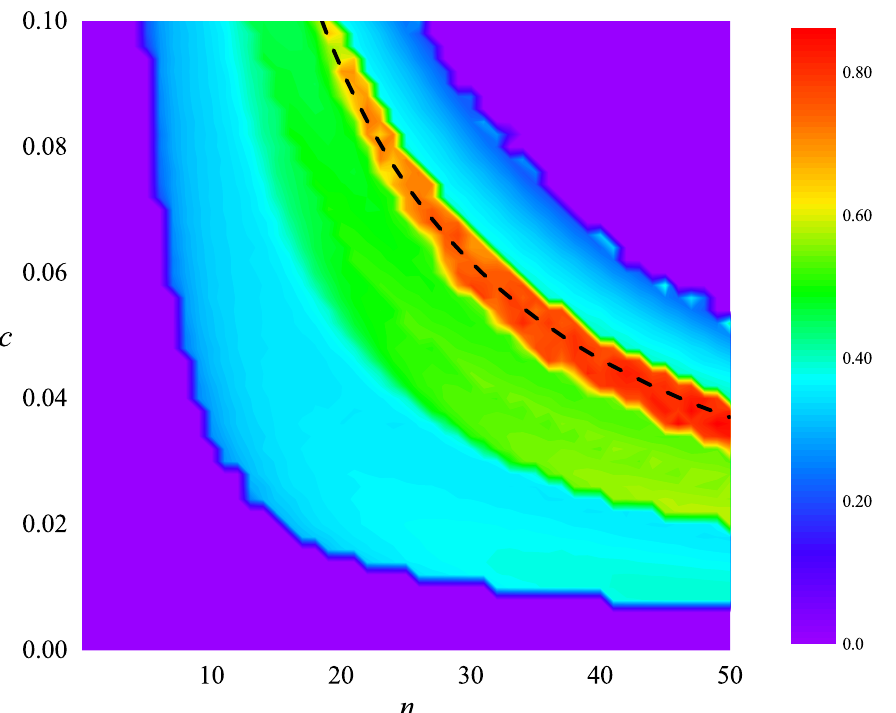
Figure 8. Fraction of cooperators at the steady state as a function of the information parameters n and c . The color bar at the right-hand side indicates the value of proportion of cooperators. Approximating the red area in the figure yields the black curve shown in the figure; the mathematical expression for the black curve is: n × c = 1.85. Other parameters are set as: L × L = 100 × 100, q = 0.5, and T =